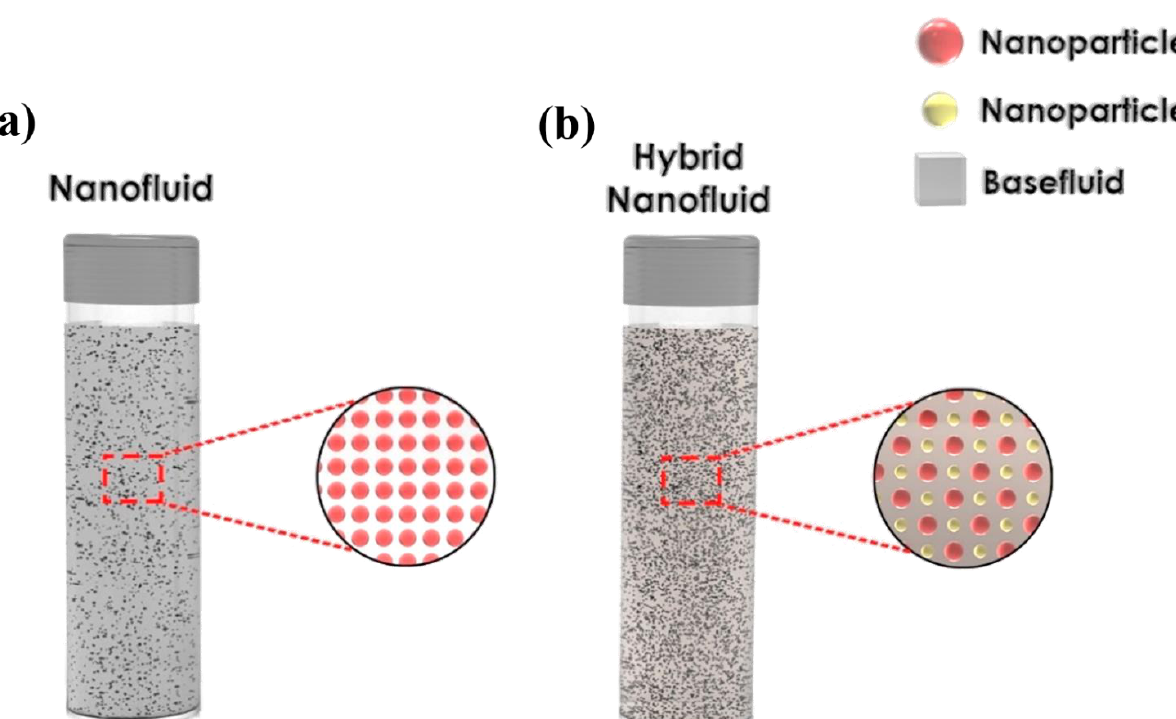
Figure 8. Schematic demonstration to compare between conventional ( a ) and hybrid ( b ) nanofluids that uses the same base fluid.